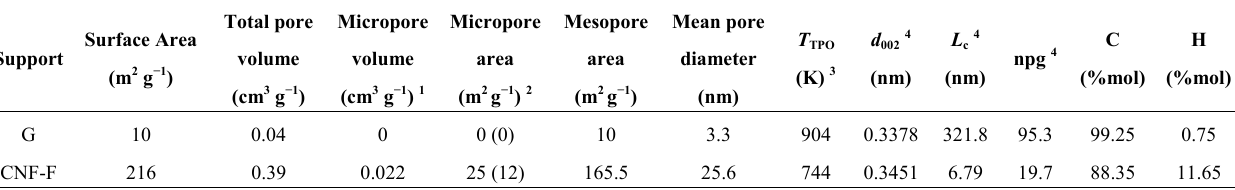
Table 1. Physicochemical properties of the supports.